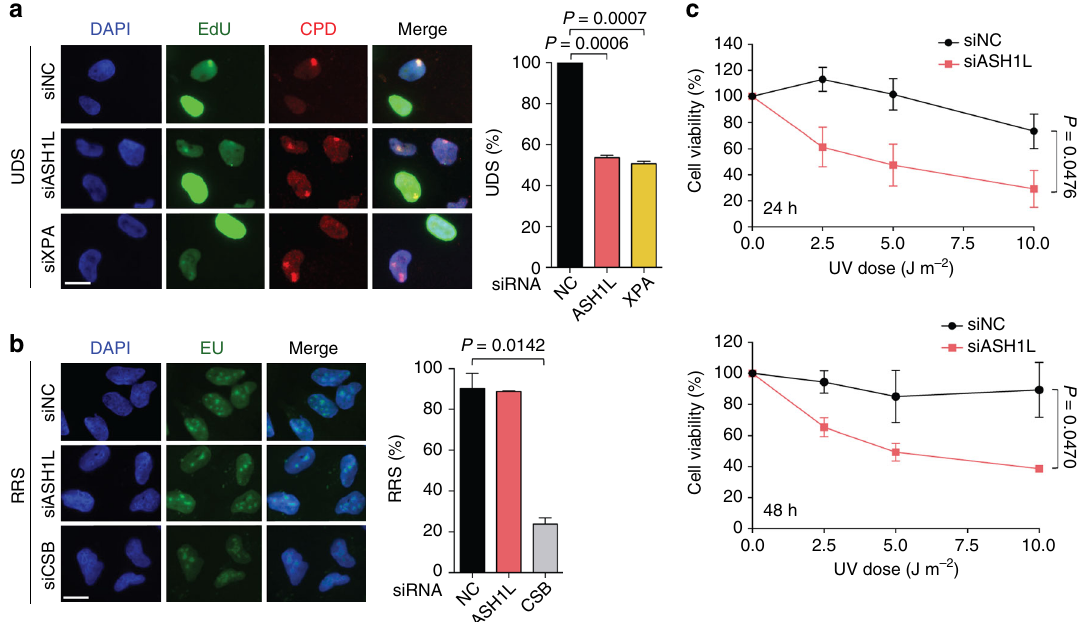
Fig. 3 Impaired GG-NER activity upon ASH1L depletion. a Unscheduled DNA synthesis (UDS). U2OS cells were transfected with siRNA and UV-irradiated (100 J m – 2 ) through 5- µ m fi lter pores 48 h later. EdU was added after a 2-h recovery to allow for 6 – 4PP excision, and fl uorescence re fl ecting UDS was measured after another 1-h period. S-phase cells were excluded from quanti fi cation ( n = 3 with at least 100 cells per experiment). The UDS detected in control cells transfected with non-coding (NC) RNA is set to 100% and error bars show s.e.m. (one-sample t-test); scale bar = 15 µ m. b Recovery of RNA synthesis (RRS). U2OS cells were transfected with siRNA and globally UV-irradiated (10 J m – 2 ) 48 h later. Next, the cells were allowed to recover for 4 h before the addition of EU for 2 h. The resulting nuclear fl uorescence, shown as the percentage of the corresponding values in unirradiated controls, re fl ects RNA synthesis ( n = 3 with at least 100 cells per experiment; two-tailed t-test). c UV light sensitivity. HeLa cells were irradiated with the indicated UV doses and their viability was measured after 24 and 48 h ( n = 3, each experiment with 4 replicates; two-tailed